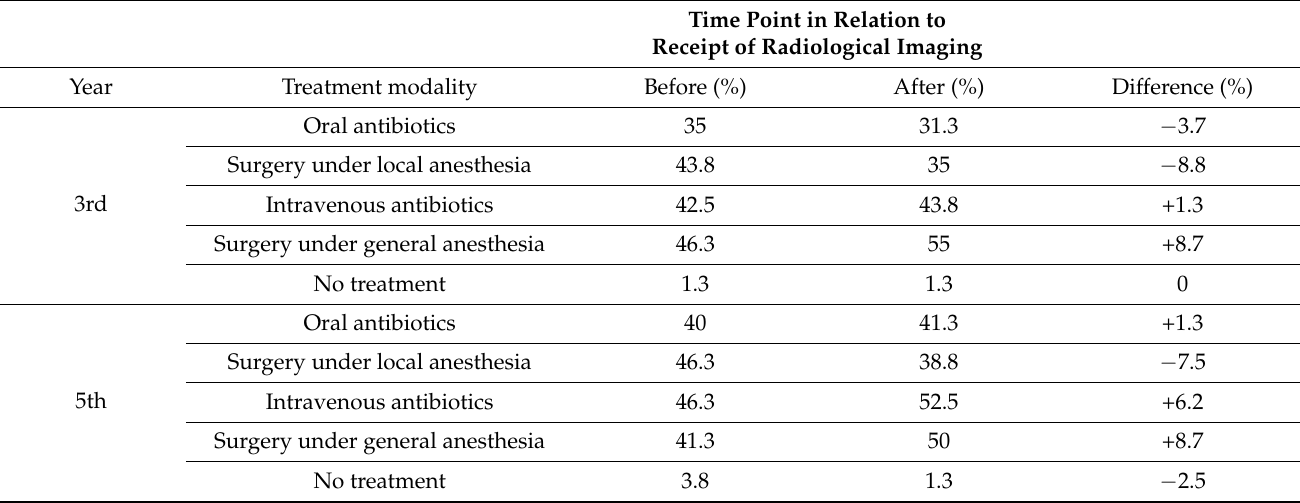
Table 3. Choice of treatment before and after receipt of radiological images. Time Point in Relation to Receipt of Radiological